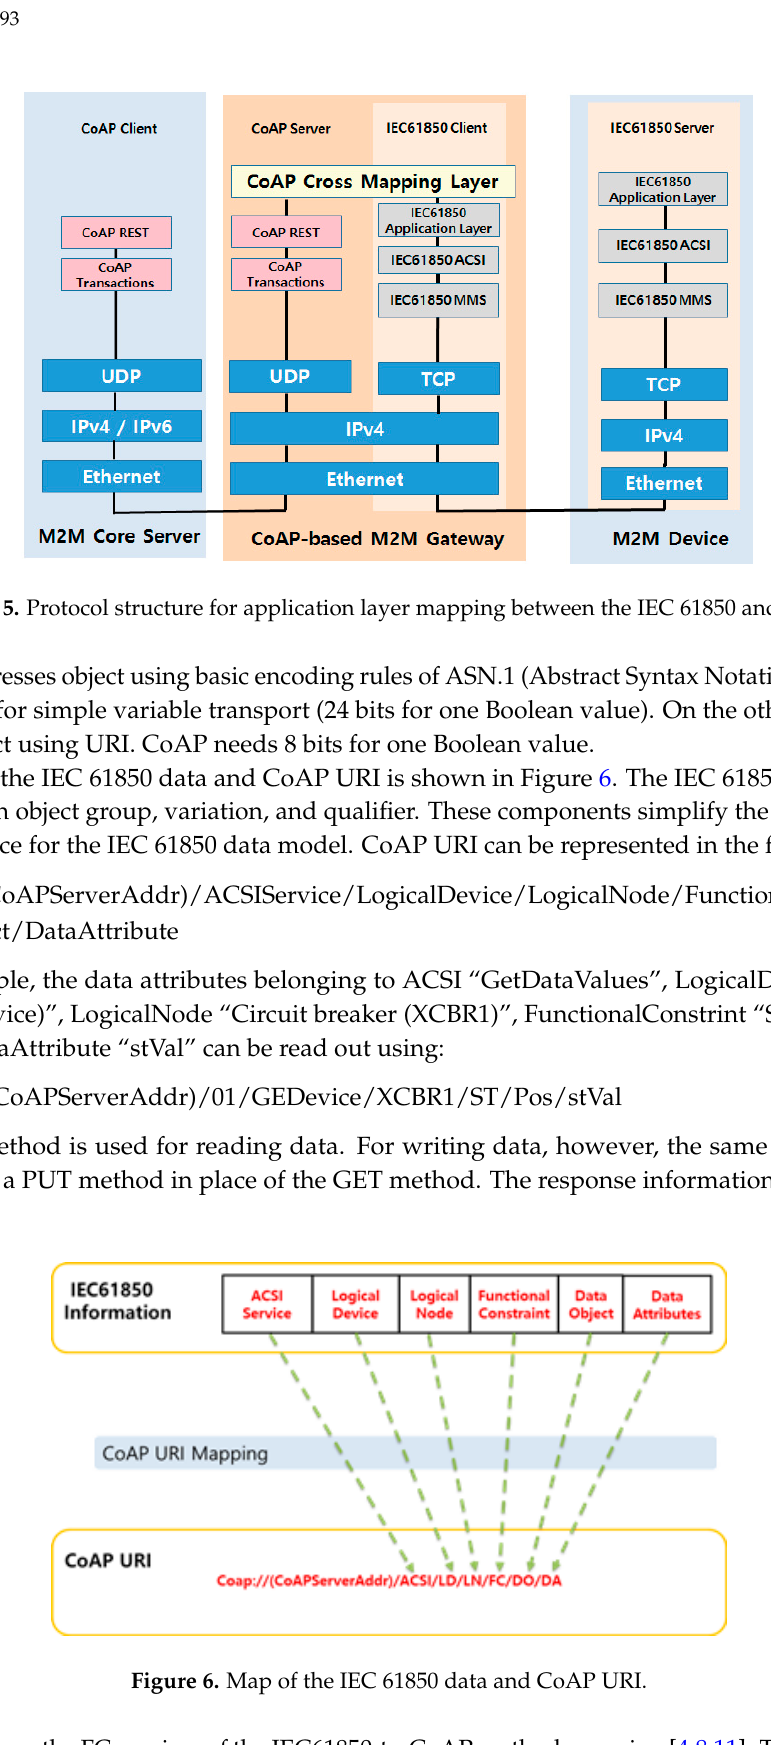
Figure 6. Map of the IEC 61850 data and CoAP URI.